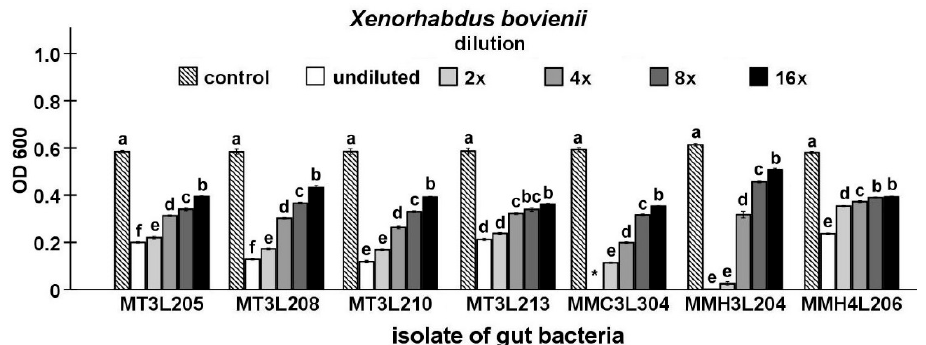
Figure 4. Antagonistic activities of different dilutions of culture supernatants from selected M. melolontha midgut isolates against X. bovienii shown by MID tests. The same letters mean no significant di ff erences between the activities of supernatants from the same midgut isolate. *—no bacterial growth.